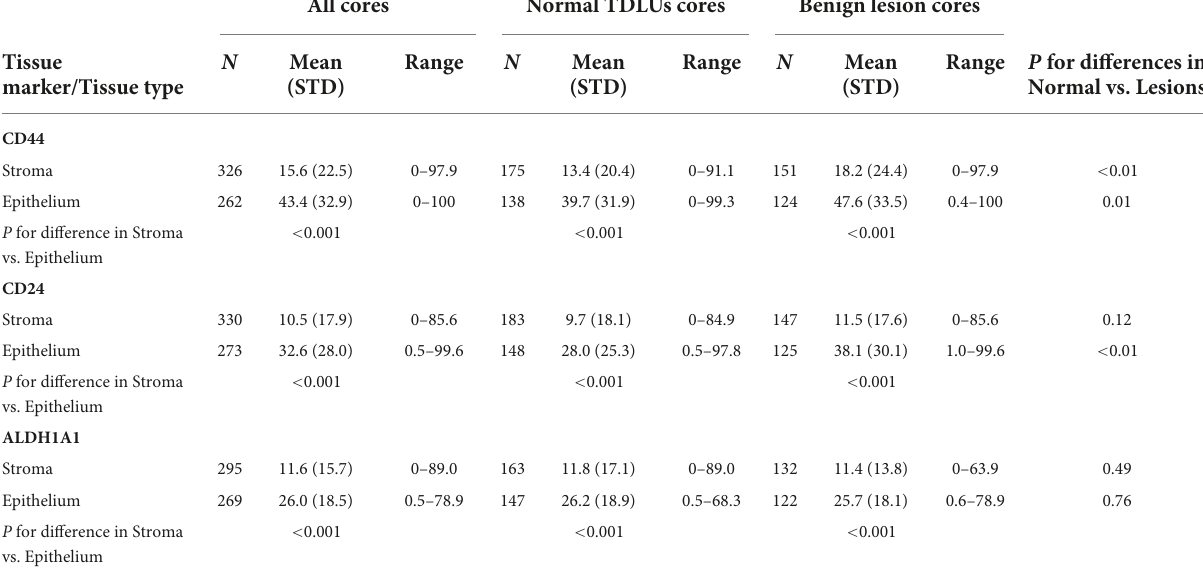
TABLE 1 Distribution of continuous marker staining (% positivity) assessed with Definiens using a single tissue microarray from Nurses’ Health Study I and Nurses’ Health Study II. All cores Normal TDLUs cores Benign lesion cores Tissue marker/Tissue type